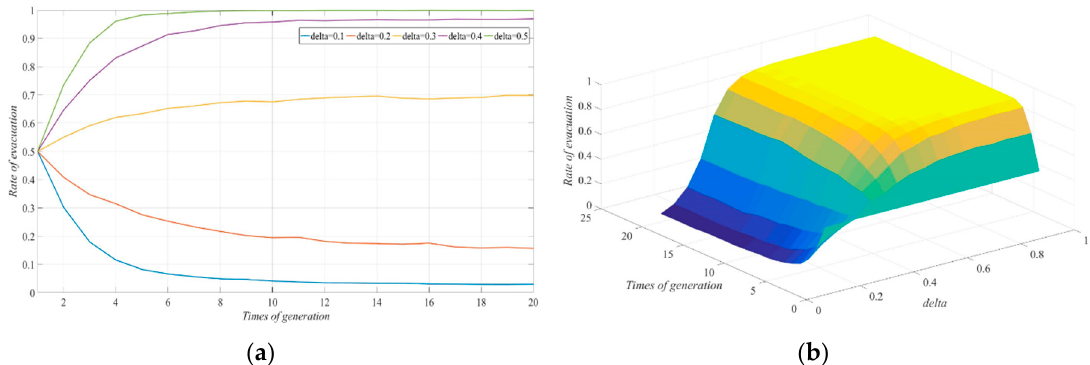
Figure 3. The effect of changes in δ on the evolution of evacuation systems: ( a ) two-dimension; ( b ) three-dimension.